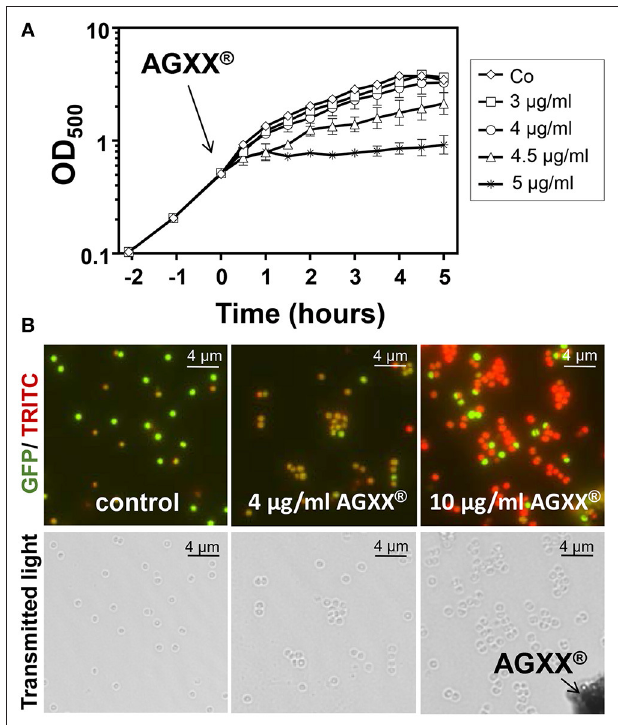
FIGURE 1 | AGXX ® has a strong antimicrobial effect on S. aureus USA300. (A) Growth curves of S. aureus USA300 were performed in RPMI medium which was exposed to 3–5 µ g/ml AGXX ® stress at an OD 500 of 0.5. The results are from 3 biological replicate experiments. Error bars represent the standard deviation (SD). (B) Viability of S. aureus USA300 wild type was analyzed before and 30min after exposure to sub-lethal (4 µ g/ml) or lethal amounts (10 µ g/ml) of AGXX ® at OD 500 of 0.5 using the LIVE/DEAD TM BacLight TM Bacterial Viability Kit. Live and dead S. aureus USA30 cells were visualized with a fluorescence microscope (Nikon, Eclipse, T i 2). S. aureus with an intact cytoplasmic membrane shows green fluorescence and dead cells with damaged membranes exhibit red fluorescence. The black arrow denotes AGXX ®